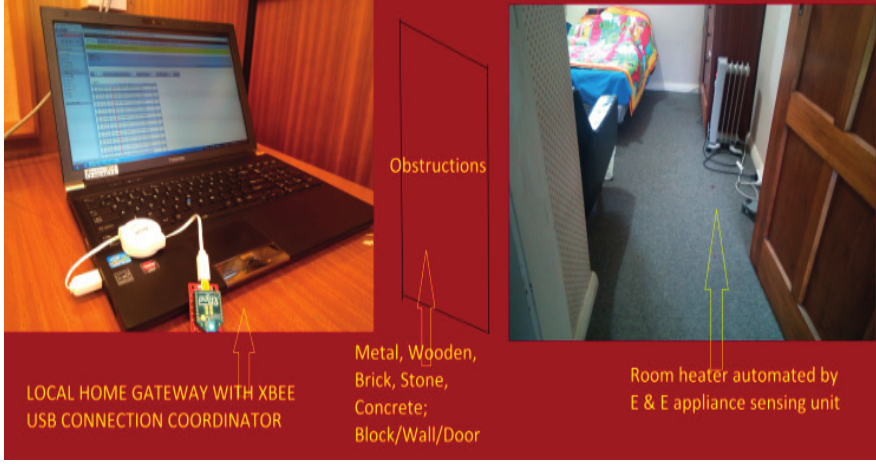
Figure 13. Monitoring system with various types of obstacles.